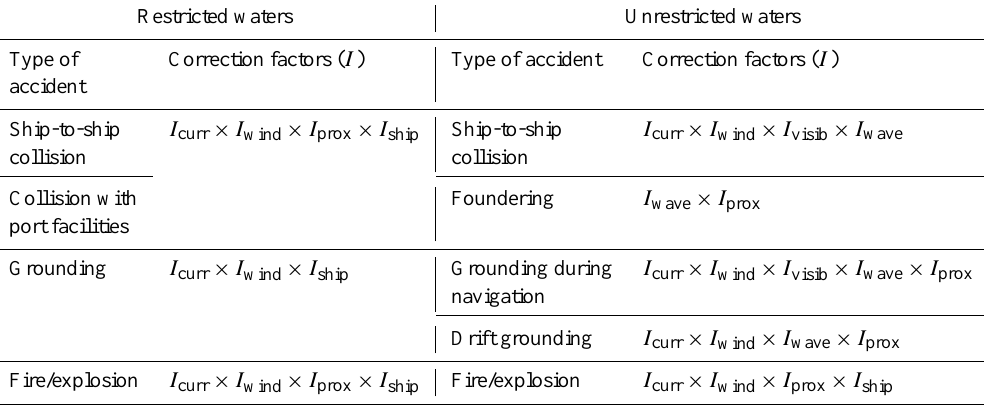
Table 1. Summary of multiple correction factors used by each type of accident ( I curr : correction factor due to currents; I wind : correction factor due to wind; I prox : correction factor due to proximity to coast; I ship : correction factor due to ship type; I visib : correction factor due to visibility; I wave : correction factor due to